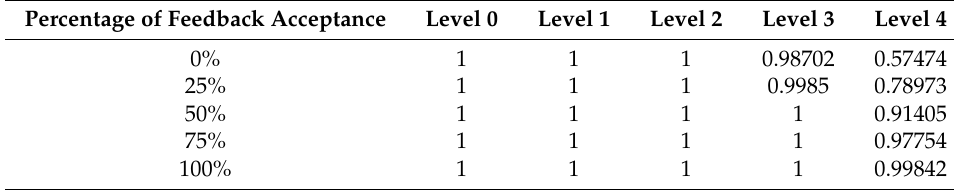
Table 3. User trust levels concerning autonomy after 250 runs, when there is no error and the user is